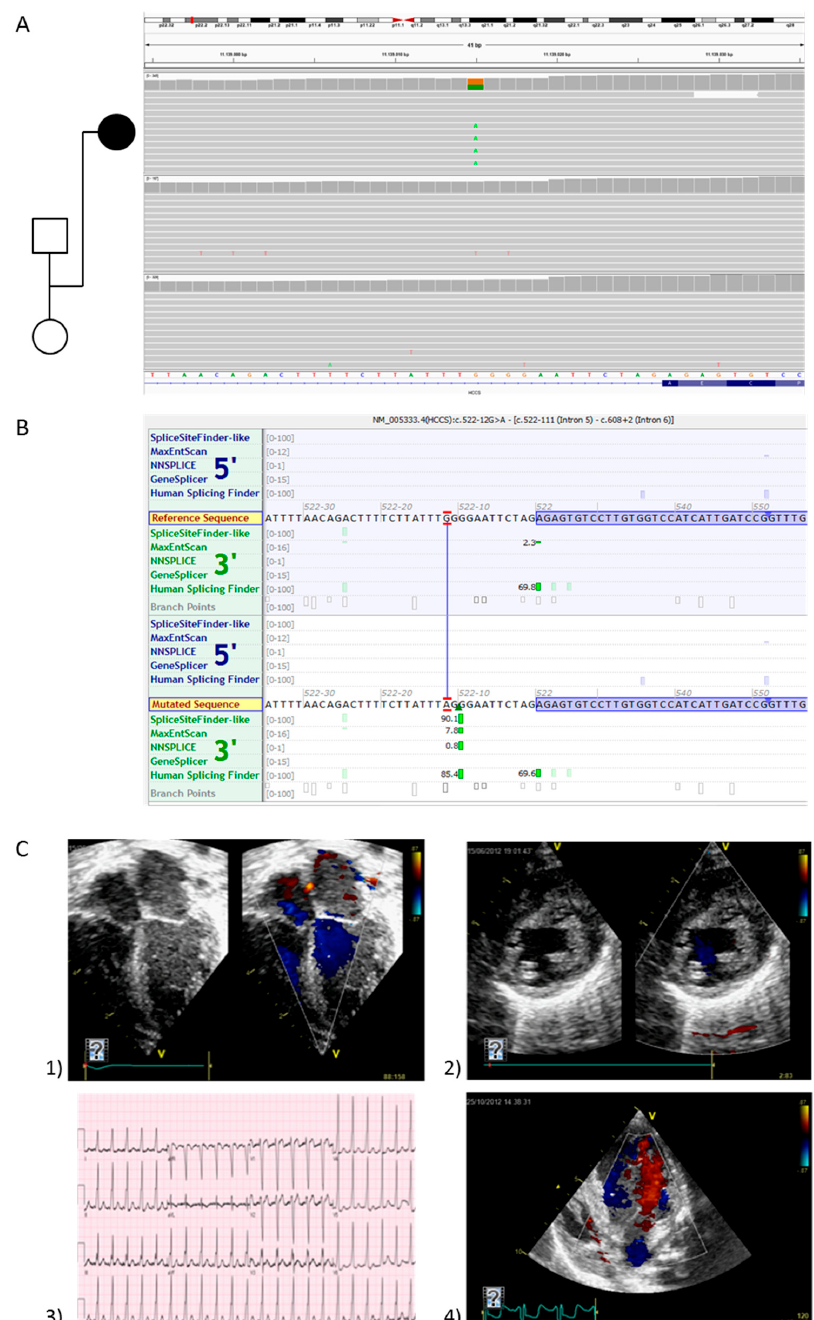
Figure 2. Clinical presentation and genetic findings of the patient with HCCS variant. ( A ) Trio-WES identified a de novo variant (NM_ 005333.4:c.522-12G>A) in HCCS gene (OMIM * 300056), predicted to create a new splice-site 12 bases upstream the canonical acceptor site of exon 6 ( B ). ( C ) Two- dimensional echocardiogram of patient #14 at birth ( 1 ) and 1 month later ( 2 ), showing mild left ventricular hypertrophy and dilation with apical non-compaction and mild mitral valve insufficiency, with normal right ventricle function and volumetry. Electrocardiogram ( 3 ) and echocardiogram ( 4 ) at 6 months of age, showing severe left ventricular dysfunction with a “foamy” appearance of the myocardium. The list of pathogenic and likely pathogenic identified variants is reported in Table